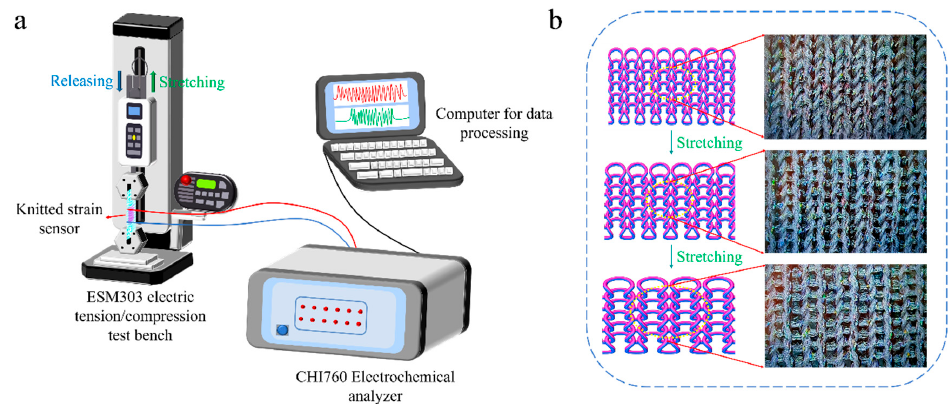
Figure 5. Research on sensing mechanism of the knitted strain sensor, ( a ) illustration of the measuring device, and ( b ) loop change of the strain sensor during the horizontal stretching process. Sensitivity is one of the critical parameters in determining a sensor’s performance. It usually represents the ratio of sensor output to input, elaborating the accuracy and effec- tiveness of the sensor [44]. GF is traditionally described as the gauge factor, which is de- fined as the following Formula (7).